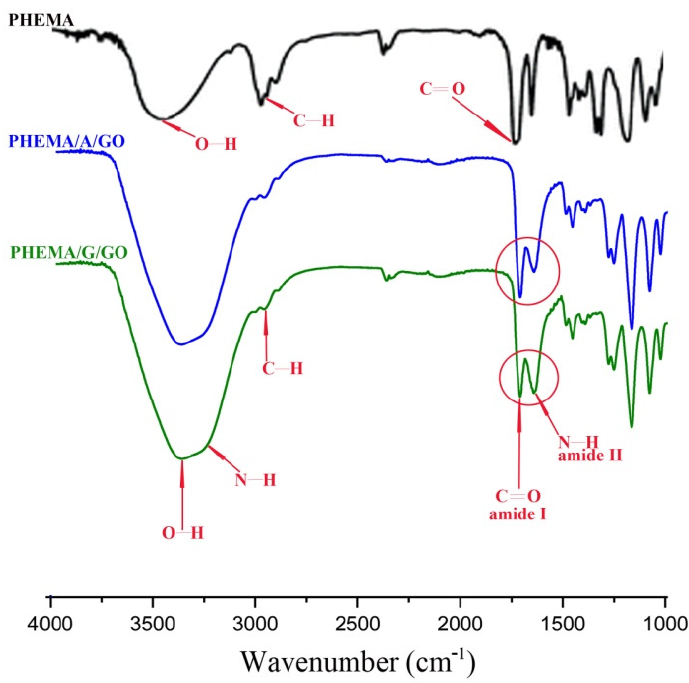
Figure 1. FTIR spectra of PHEMA, PHEMA/A/GO and PHEMA/G/GO hydrogels.